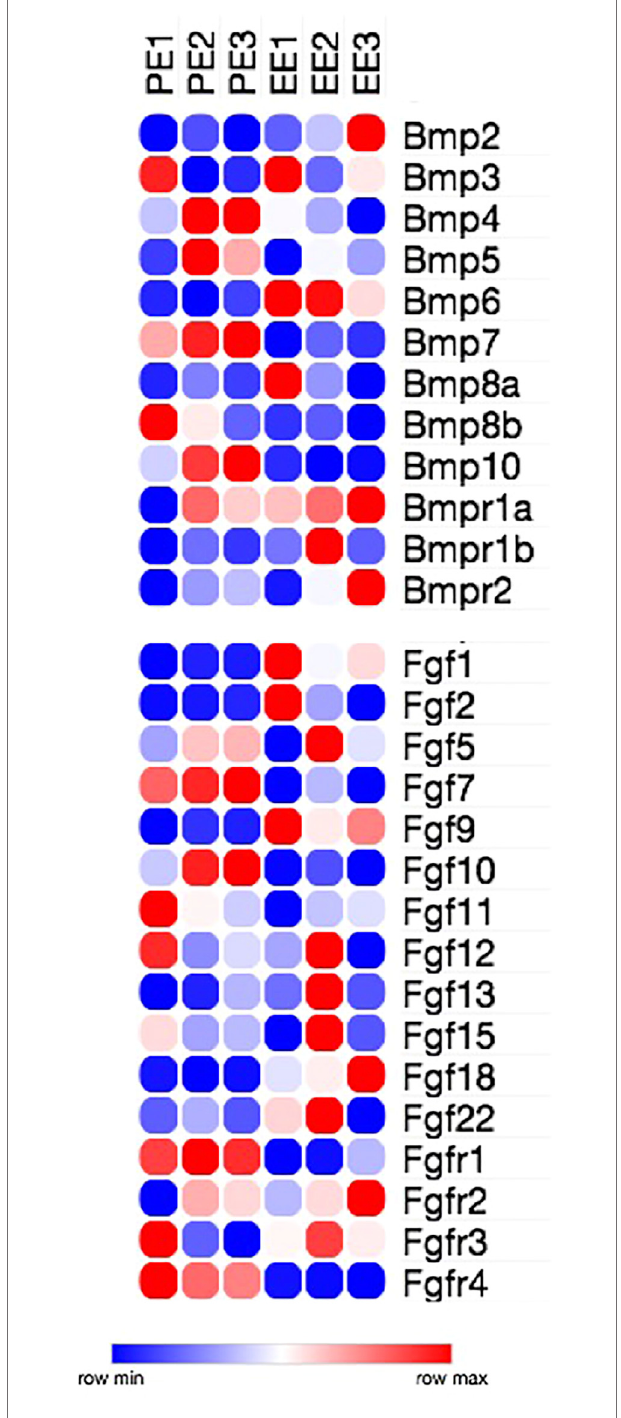
FIGURE 4 | Heatmap representation of Bmp and Fgf family members expression asrevealedbyRNAseqanalysesinmouseE9.5 PE(PE1,PE2and PE3) and E10.5 embryonic epicardium (EE1, EE2 and EE3).